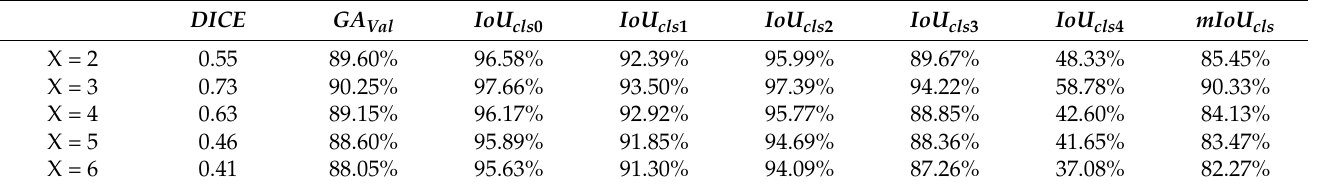
Table 2. The global accuracy rate and cross merge ratio index of the model under different